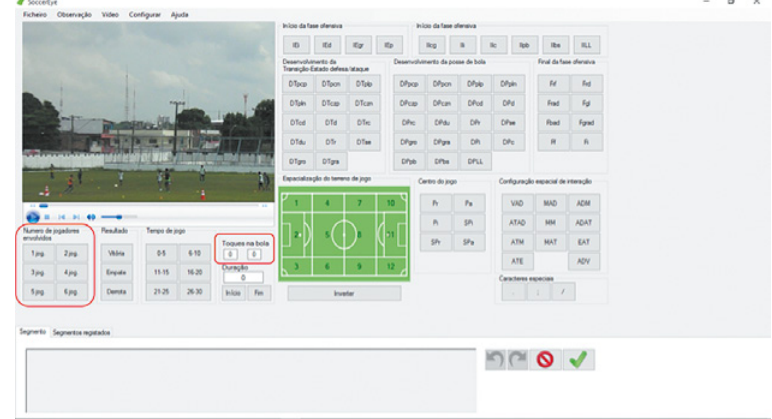
Figure 2. Adaptation of SoccerEye recording instrument 30